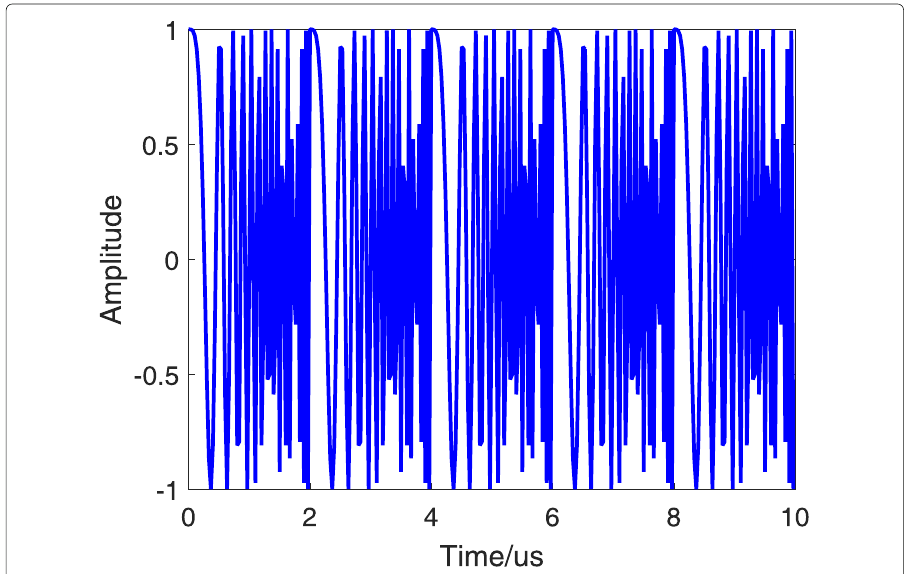
Fig. 1 The time domain of SMSP jamming (B=15MHz, T=10us,